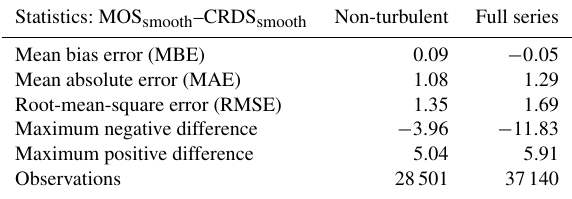
Table 1. Statistics for the calculated differences between the smoothed MOS and smoothed CRDS data series in both the non- turbulent time period and full-field calibration period. The unit for error and difference values is parts per million